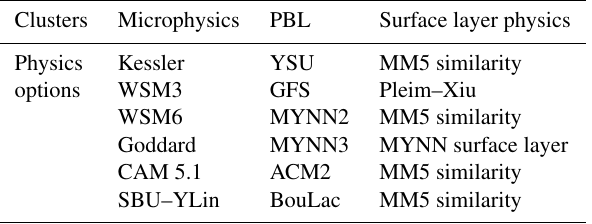
Table 3. Employed physics configuration of Set 3, which summa- rizes 6 × 6 configurations. The PBL is used with certain surface layer physics indicated in the same row of PBL